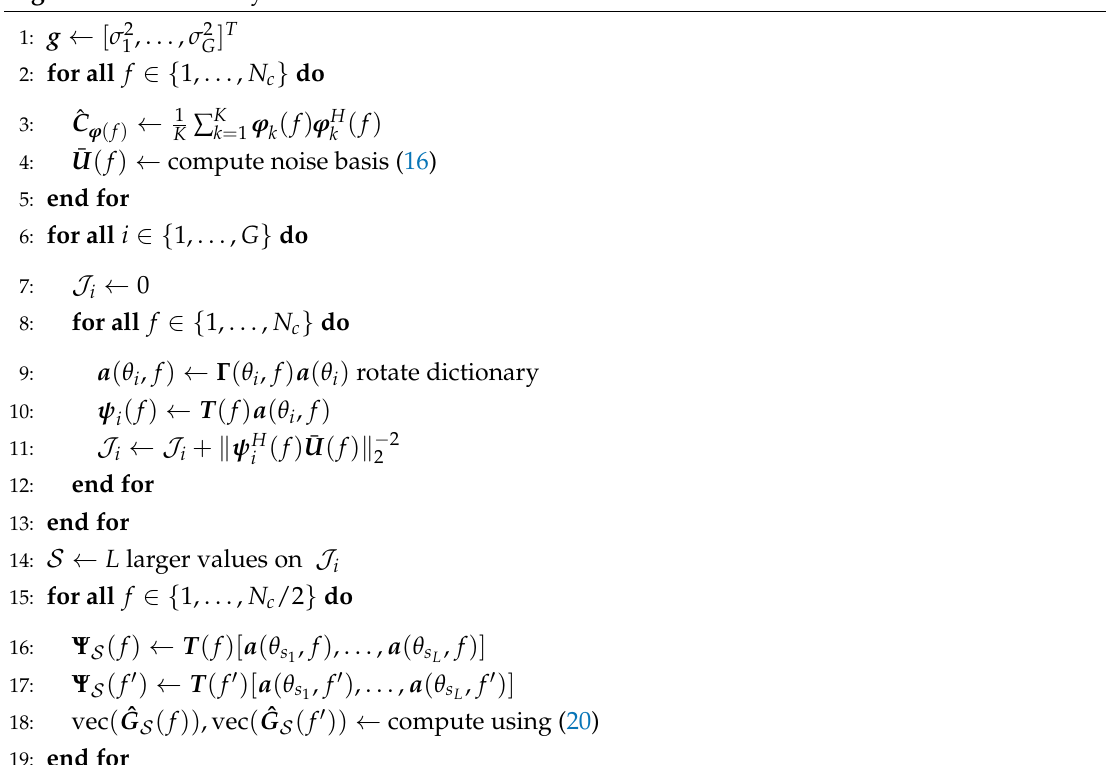
Algorithm 1 Dictionary-Rotation Wideband